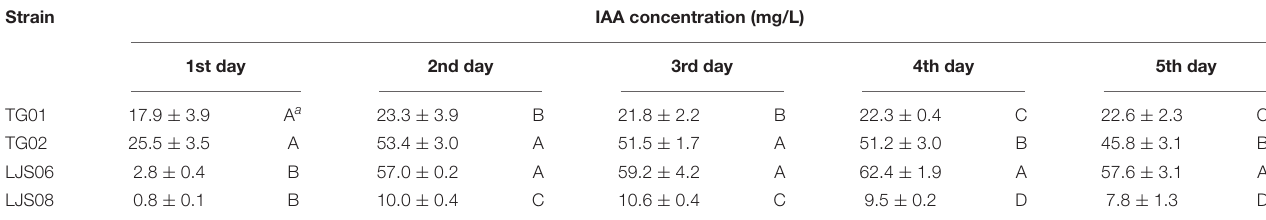
TABLE 6 | Production of indole-3-acetic acid by four Streptomyces spp. in LB broth containing 5 mM of l-tryptophan at 30 ◦ C for 5 days. Strain IAA concentration (mg/L)